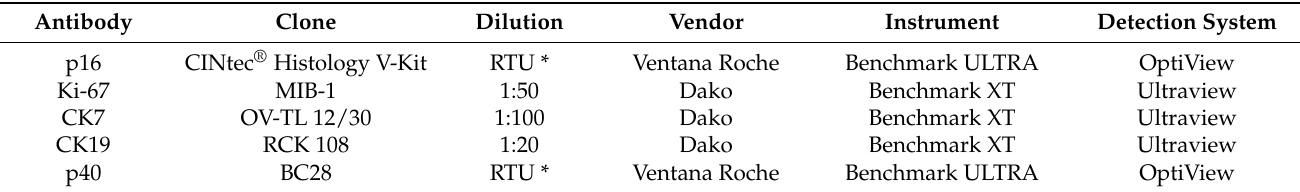
Table 1. Immunohistochemical protocols and antibodies used for the detection of p16, Ki67, CK7, CK19 and p40.